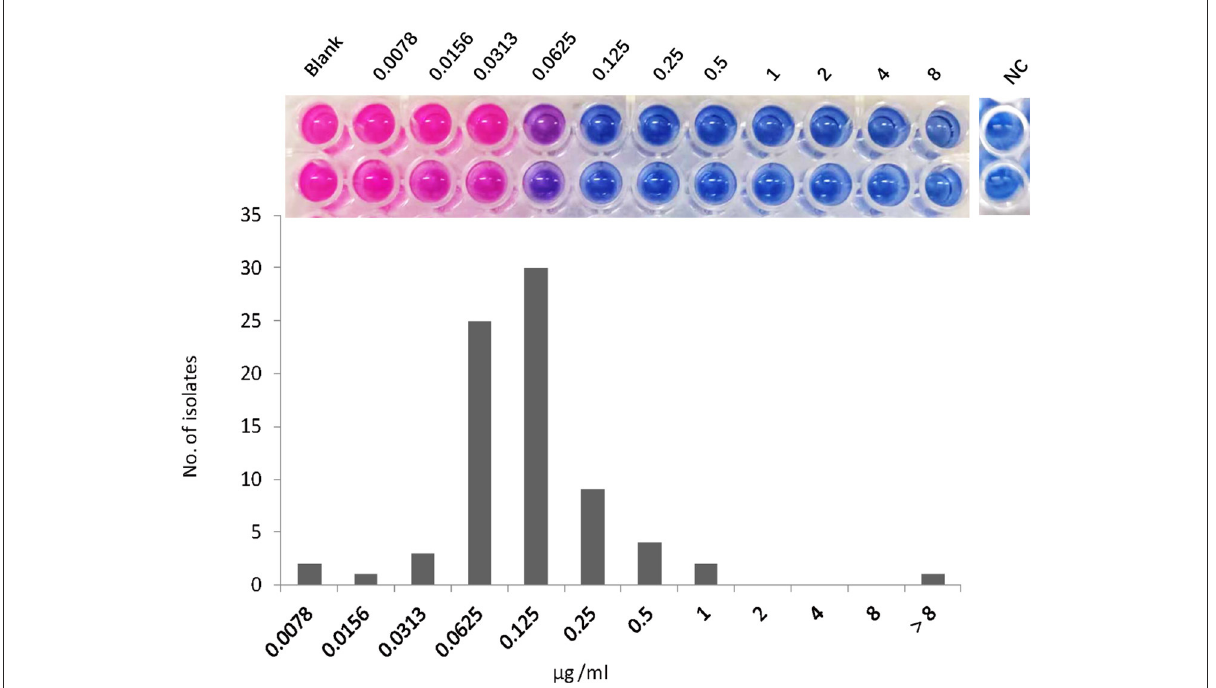
FIGURE1 The minimum inhibitory concentration (MIC) distribution of nosiheptide (NOS) against Mycobacterium abscessus isolates. The MIC was determined by microtiter plate AlamarBlue assay. The MIC outcome of NOS against M. abscessus ATCC19977 was on the top. The blank group: only bacteria without drugs; NC group: negative control group, this group was free of bacteria and drugs to prove that the experiment was not contaminated.